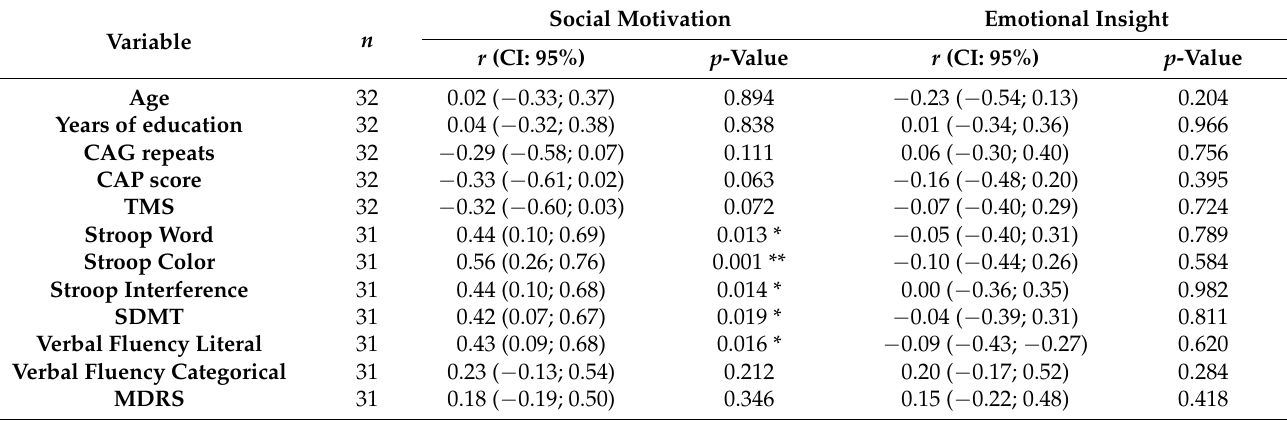
Table A2. Pearson’s correlations analysis in PreHD at